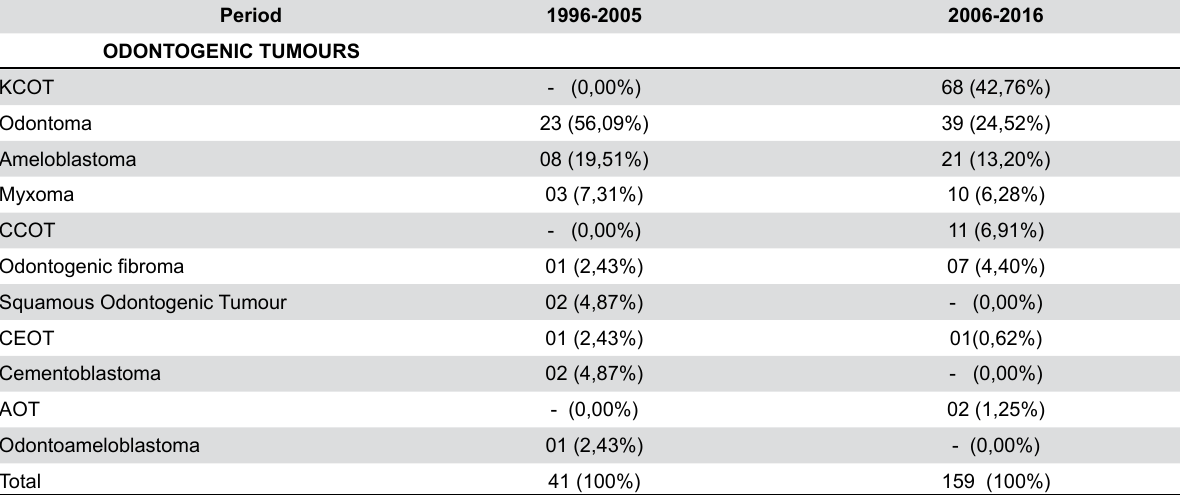
Table 1- Distribution of OTs diagnosed before and after 2005 in a Brazilian Oral Pathology Center